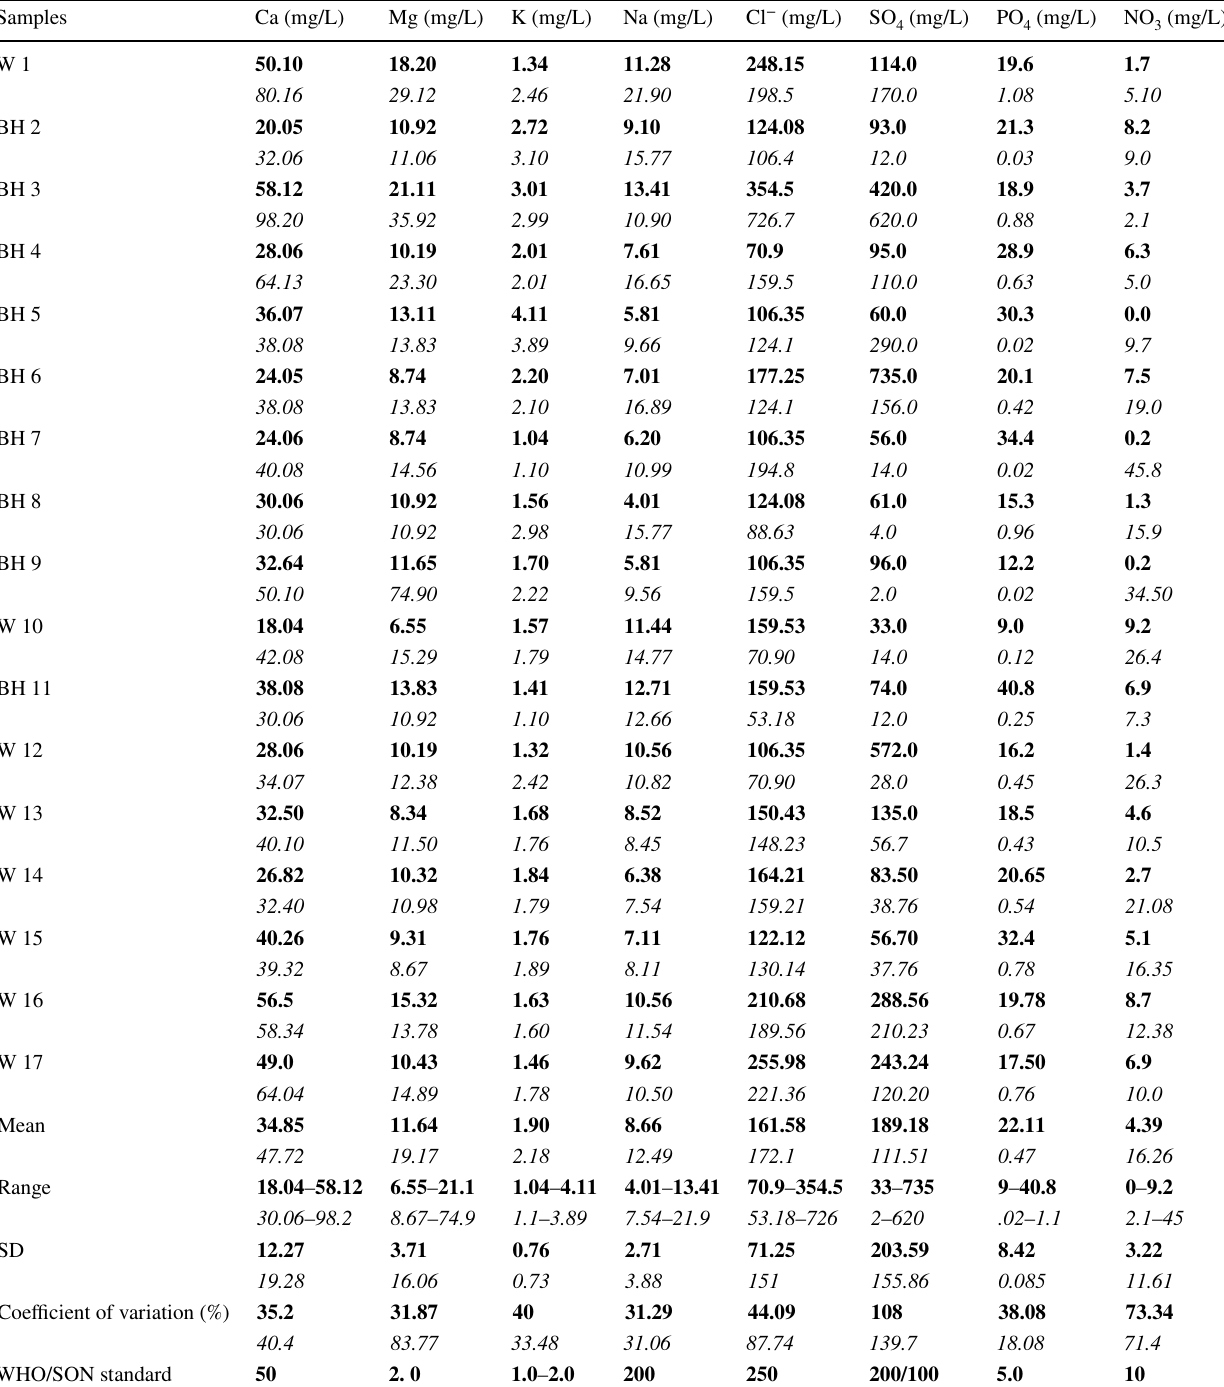
Table 2 Seasonal paired-sample statistics of macroelements and anions content of water samples obtained around the Olusosun